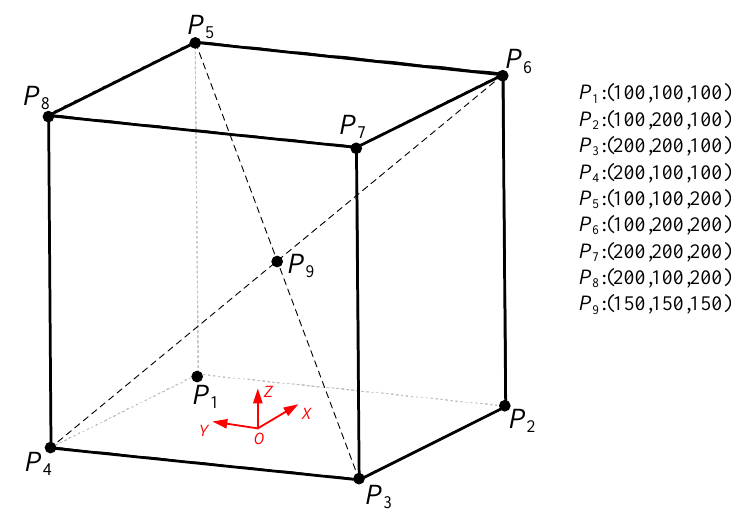
Figure 2. Location schematic diagram of the analysis point in the workspace.